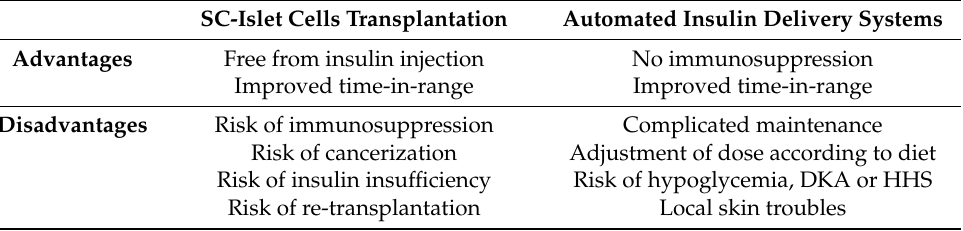
Table 1. Comparison between SC-islet cells transplantation and automated insulin delivery systems. SC-Islet Cells Transplantation Automated Insulin Delivery Systems Advantages Free from insulin injection No immunosuppression Improved time-in-range Improved time-in-range Disadvantages Risk of immunosuppression Complicated maintenance Risk of cancerization Adjustment of dose according to diet Risk of insulin insufficiency Risk of hypoglycemia, DKA or HHS Risk of re-transplantation Local skin